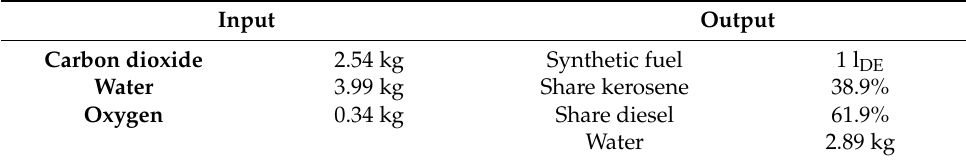
Table A1. Energy-specific material balance of the developed fuel synthesis.